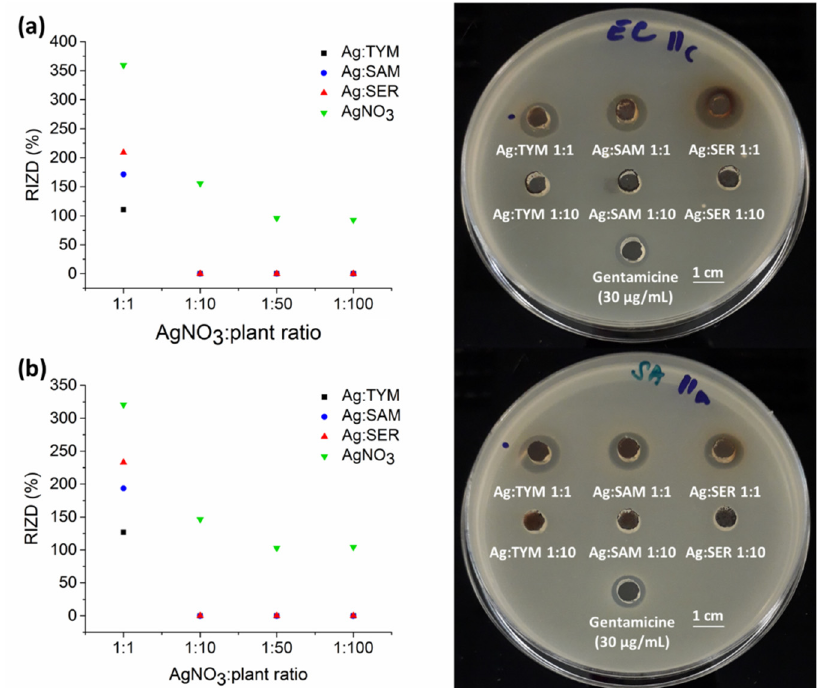
Figure 11. Left: Antibacterial activity of AgNPs-plant samples against: ( a ) E. coli and ( b ) S. aureus . Right: Representative photographs of Petri dishes after 24 h incubation. RIZD stands for relative inhibition zone diameter.